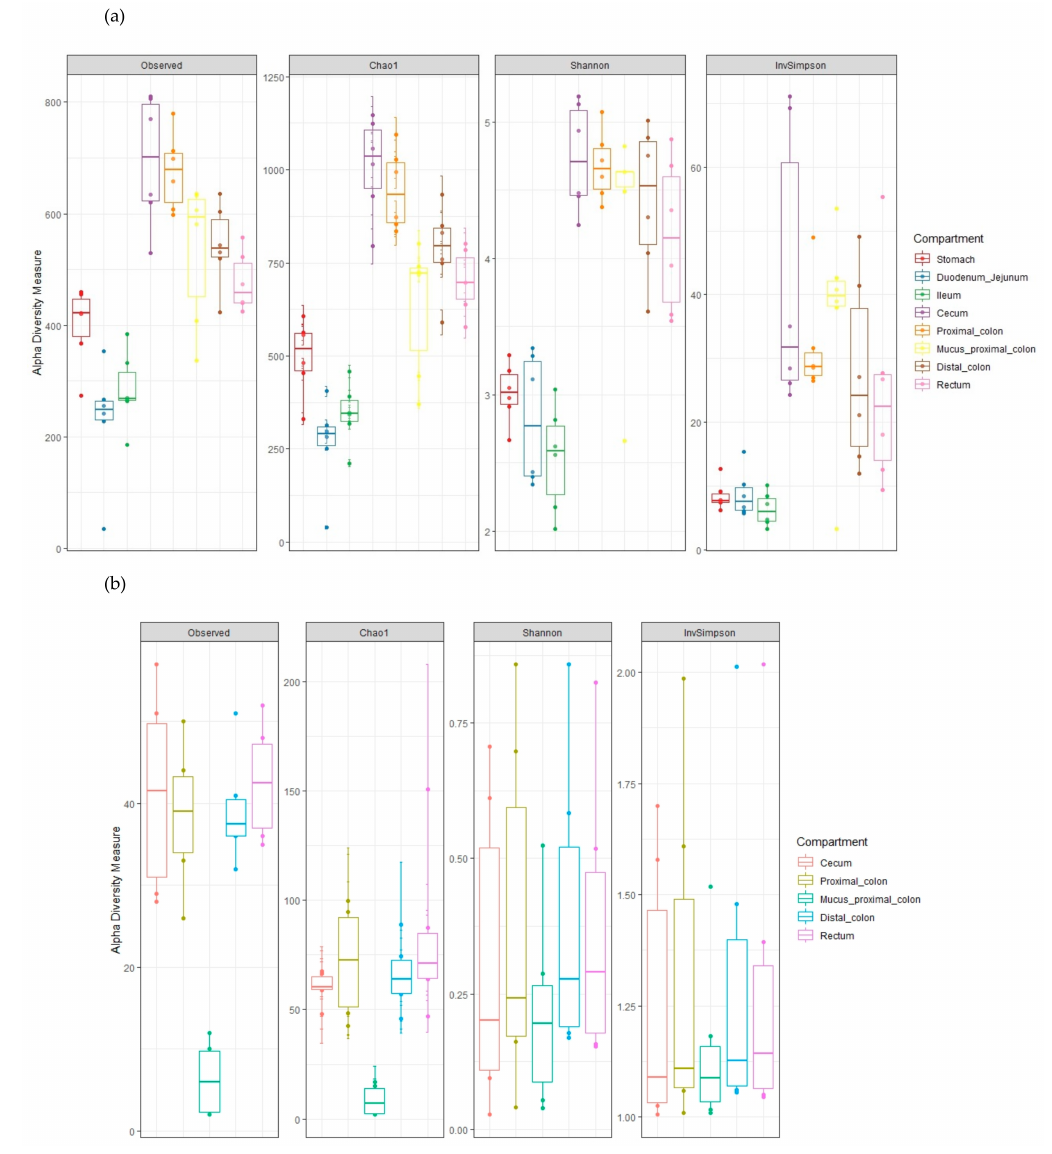
Figure 6. Alpha diversity measures on bacterial ( a ) and archaeal ( b ) OTUs across the GIT of weaning